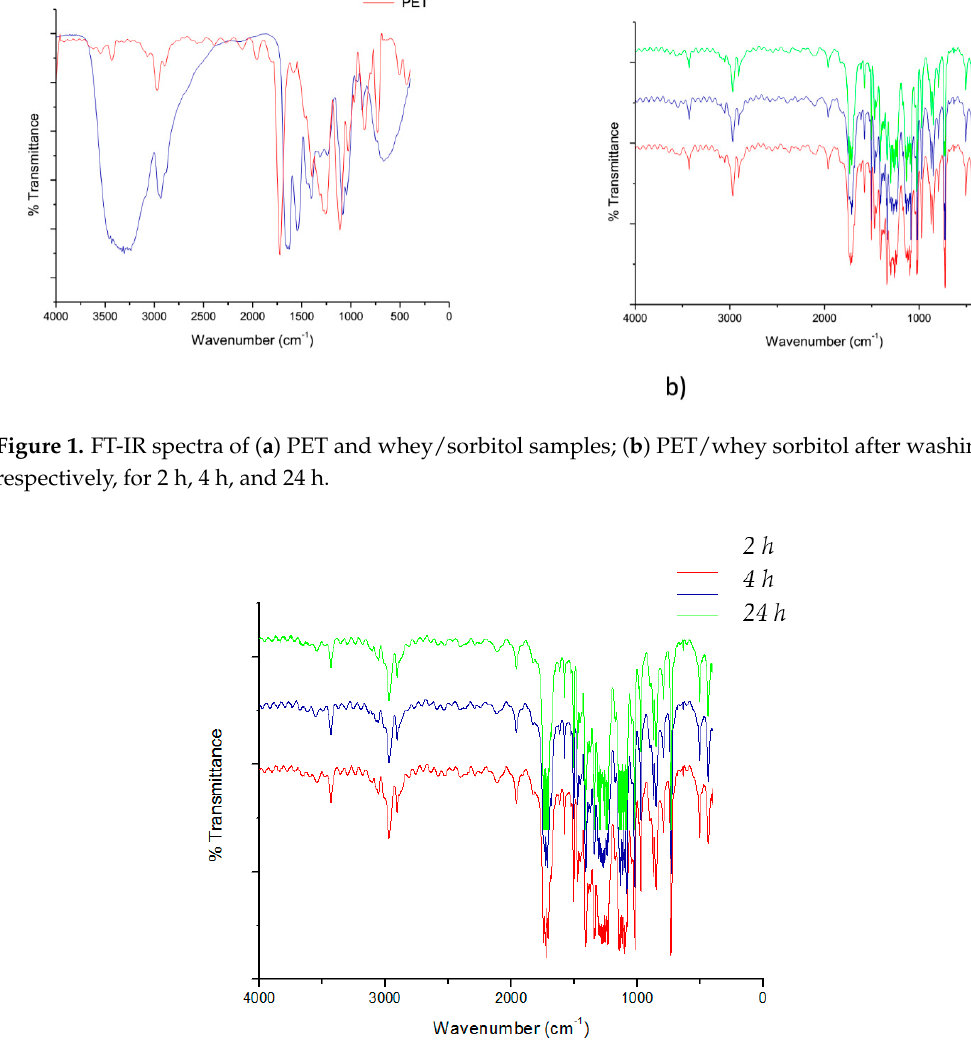
Figure 2. FT-IR spectra of samples with glycerol after washing, respectively, for 2 h, 4 h, and 24 h.